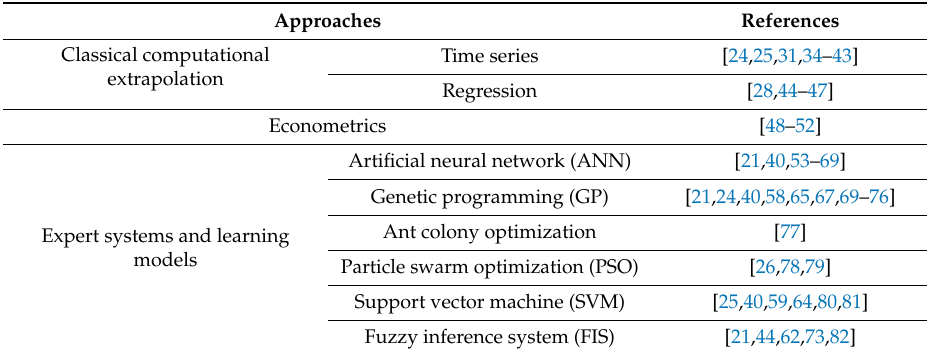
Table 1. Analyzing previous studies, based on their approaches to address energy consumption prediction